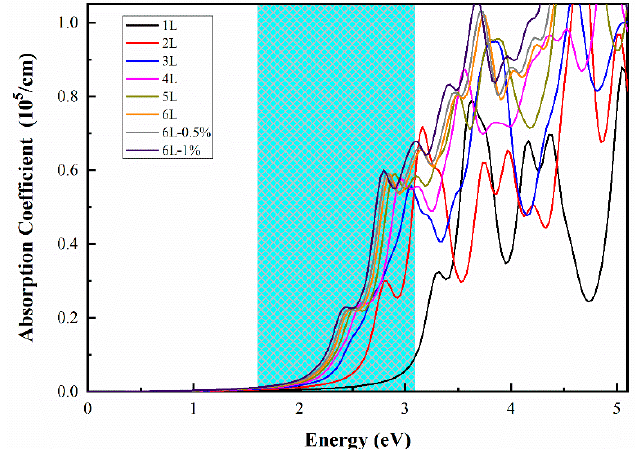
Figure 5. Optical absorption spectra of nL ZnO (n = 1–6) and 6L ZnO under 0.5% and 1% biaxial strain obtained using HSE06 calculations. The energy range of visible light is shown on the blue background.